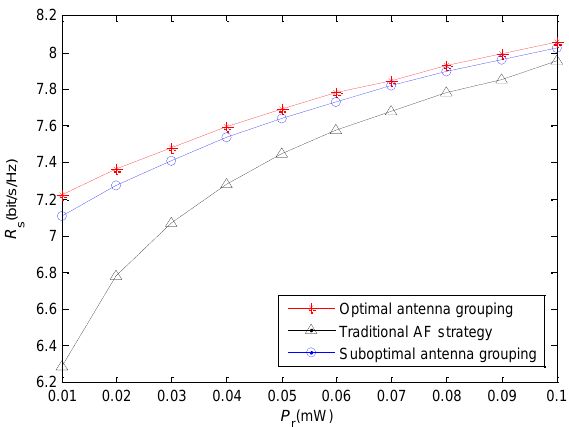
P and secrecy rate. Figure 6. Relationship between P r and secrecy r